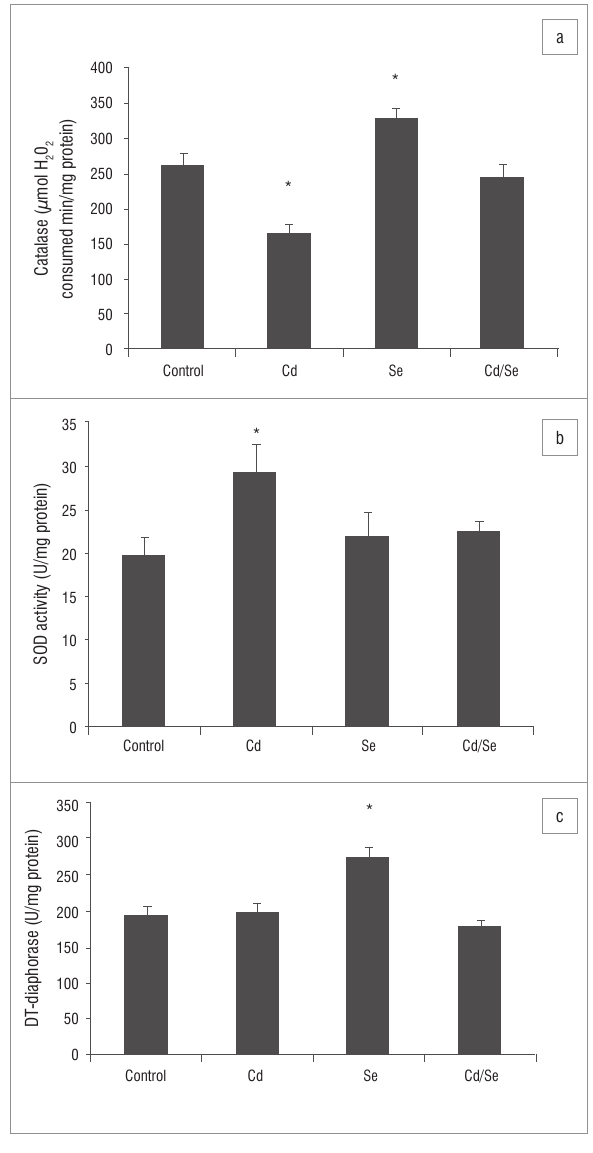
Mean±SD (a) catalase, (b) total superoxide dismutase (SOD) and (c) DT-diaphorase activities in the livers of male rats ( n =5) that received cadmium (1.67 mg/kg cadmium chloride in saline), selenium (0.23 mg/kg sodium selenite solution), cadmium and selenium (Cd/Se; 1.67 mg/kg cadmium chloride in saline and 0.23 mg/kg sodium selenite solution) or saline (control) daily (IP) for 15